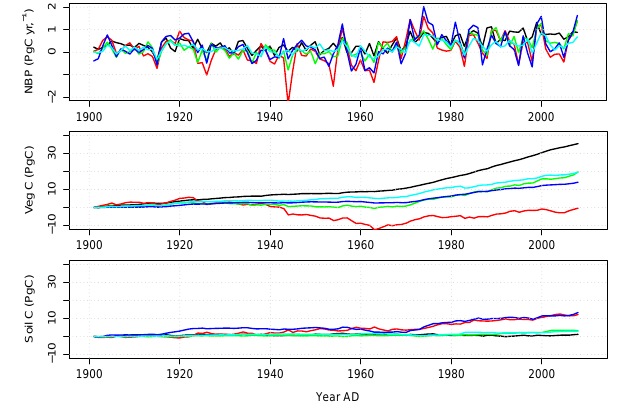
Fig. 11. Dynamic global vegetation model predictions of net carbon flux from the atmosphere to land vegetation (net biome productivity – NBP) for all of South America (a) , and cumulative carbon up- take/release by living vegetation (b) and soils (c) . NBP is defined as in Eq. (6).